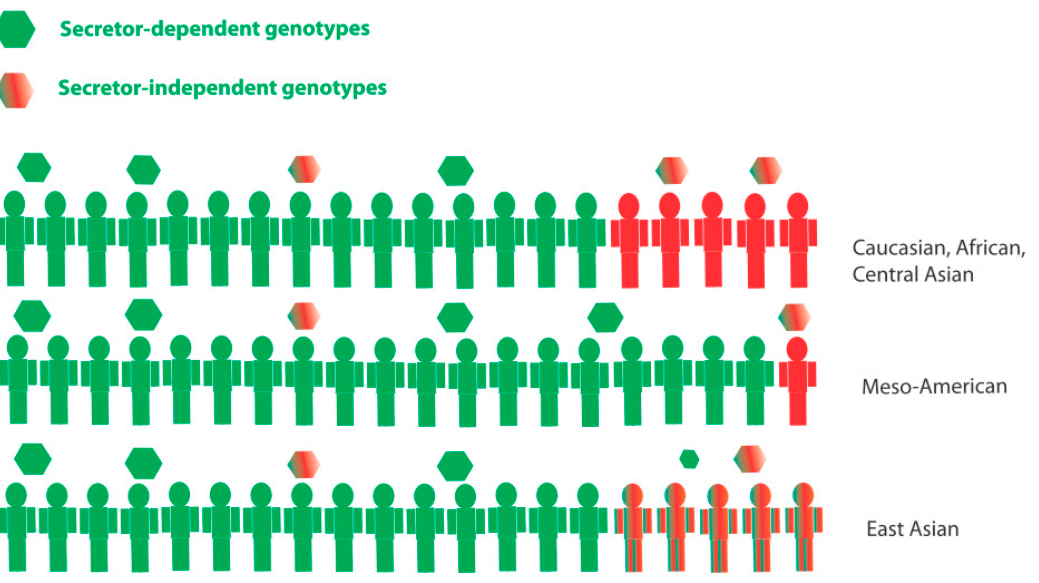
Figure 2. A simplistic overview of secretor status in different population groups. Secretors (green) are susceptible to secretor-dependent norovirus genotypes, including the globally predominant GII.4 genotype. Secretors are also further susceptible to secretor-independent genotypes. Non-secretors (red) are only susceptible to secretor-independent genotypes. As of yet, no genotypes have been observed to exclusively infect non-secretors. Weak-secretors (mix red or green) are common in East Asian populations, having a reduced expression of secretor antigens, and would thus be partially susceptible to secretor-specific genotypes. The prevalence of secretors is particularly high in Meso-American populations, which may lead to a higher disease burden in the population due to (1) higher rates of GII.4 infection and (2) a larger portion of the population being susceptible to both secretor and secretor-independent